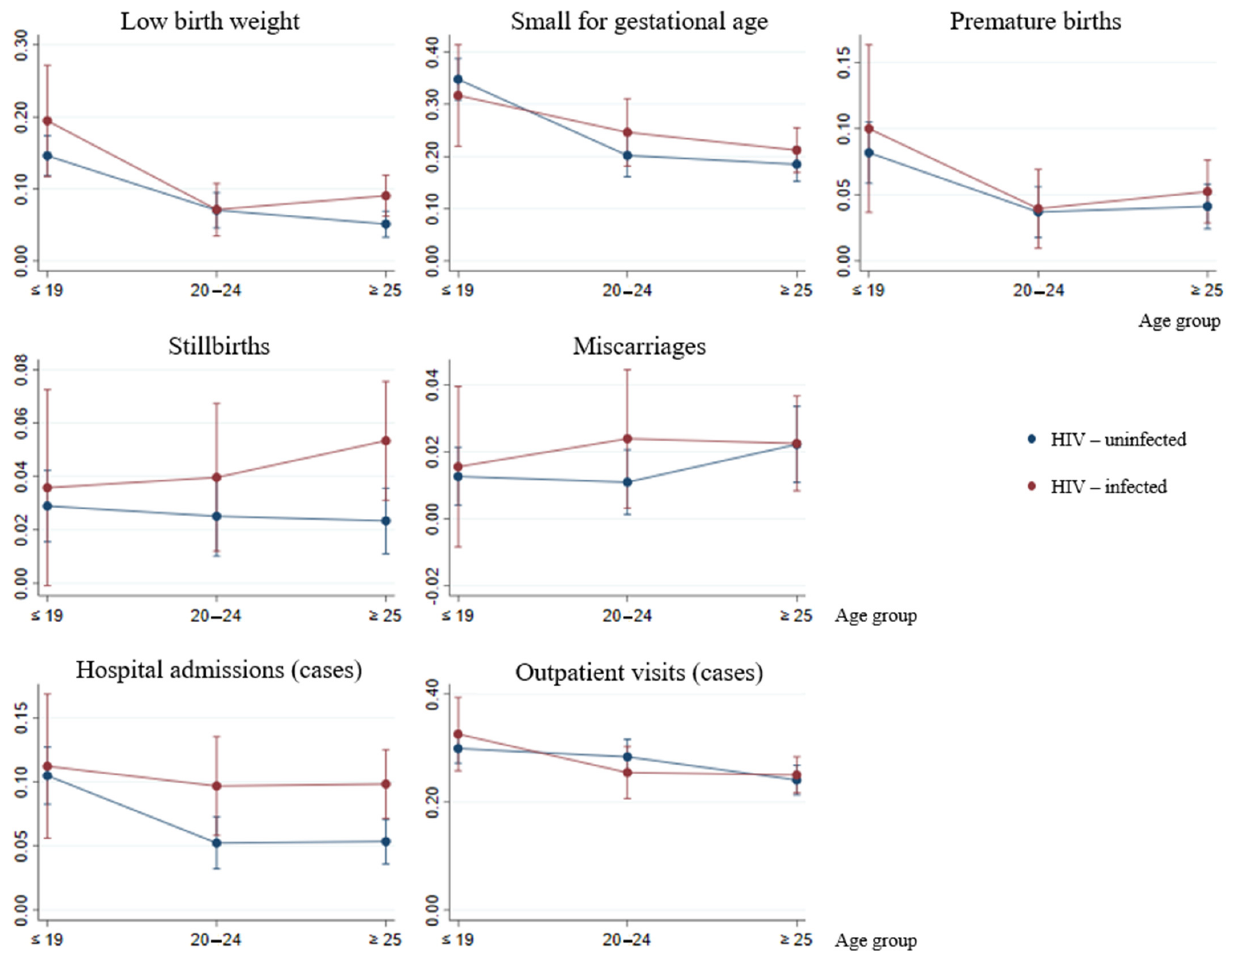
Figure 1. Age and HIV infection interaction: predictive margins with 95% CIs, by study outcome.